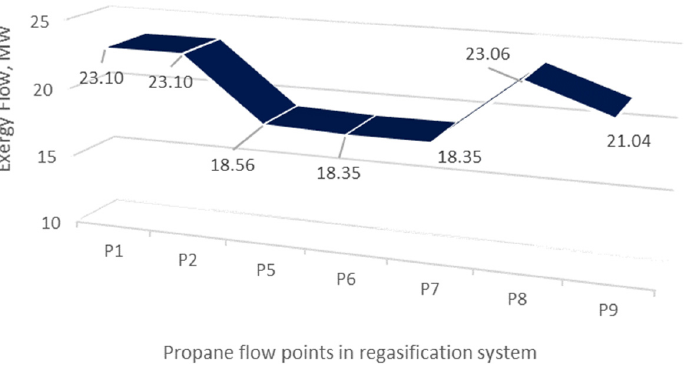
Figure 3. The values of propane exergy flow in the regasification system: P1, propane flow from LNG vaporiser to propane tank; P2, propane flow transfer by propane pump; P5, propane flow to propane preheater; P6, propane flow from propane preheater to NG trim heater; P7, propane flow from NG trim heater to propane evaporator; P8, propane flow to propane evaporator; P9, propane (liquid and vapours) flow from propane evaporator to LNG vaporiser.